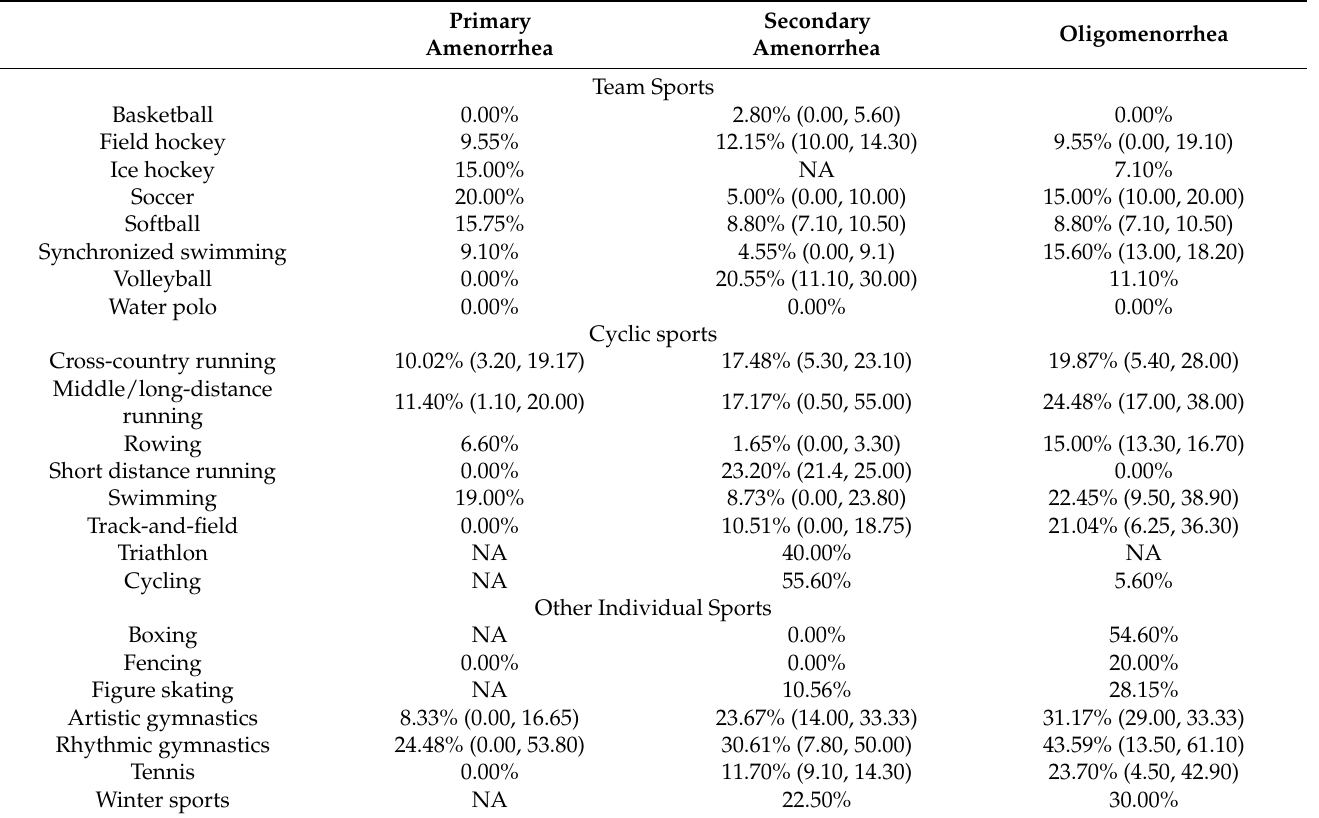
Table 6. Sports disciplines and the mean (min, max) prevalence (%) of menstrual cycle